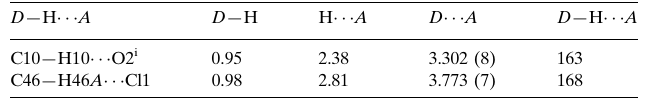
Hydrogen-bond geometry (A˚ , (cid:2)